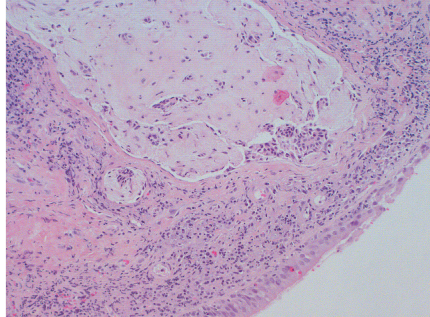
Figure 3: Small lump of chondroid appearance comprising aggre- gates of myoepithelial elements, covered by normal mucous mem- brane of respiratory type (bottom right) (hematoxylin-eosin 100x).